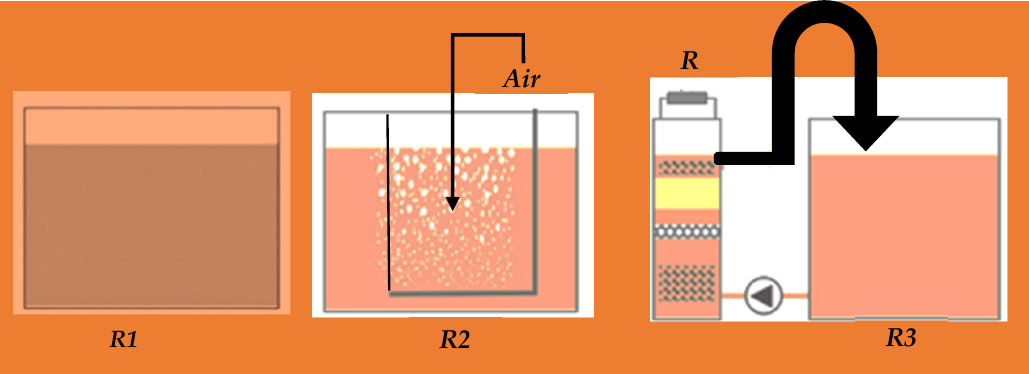
Figure 3. Reactors for the measurement of wastewater parameters; without-air reactor (R1)—the reactor 15 L and the air is interface in wastewater sewage; with-air reactor (R2)—15 L with constantly aerated wastewater; and membrane less FFC (R3)—reduces COD to 90%.